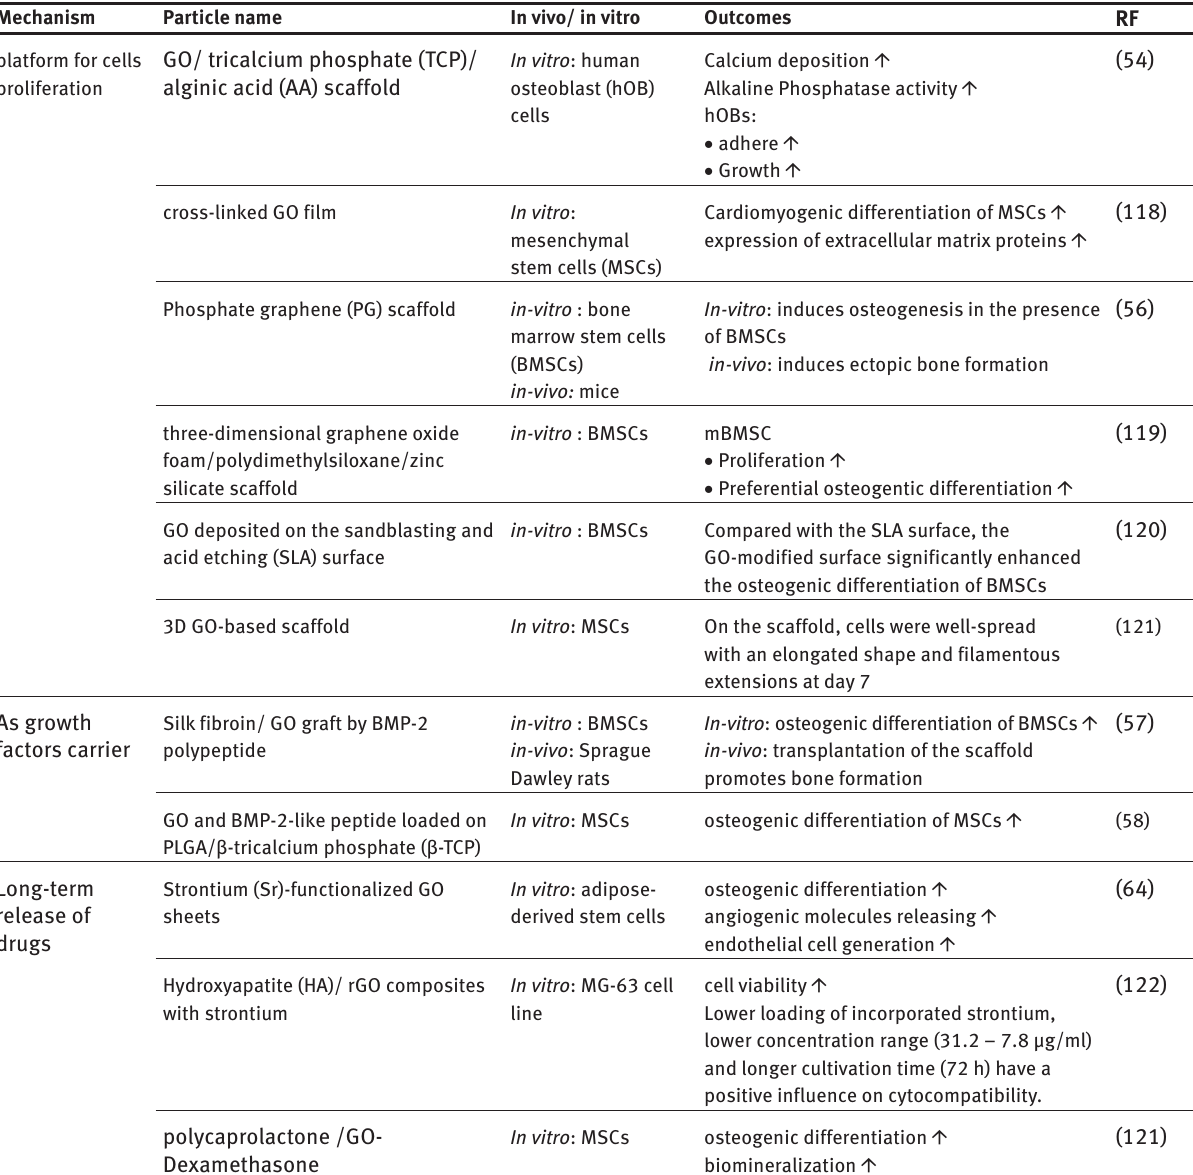
Table 2: Mechanisms of graphene oxide (GO)-based nanostructures in bone regeneration.